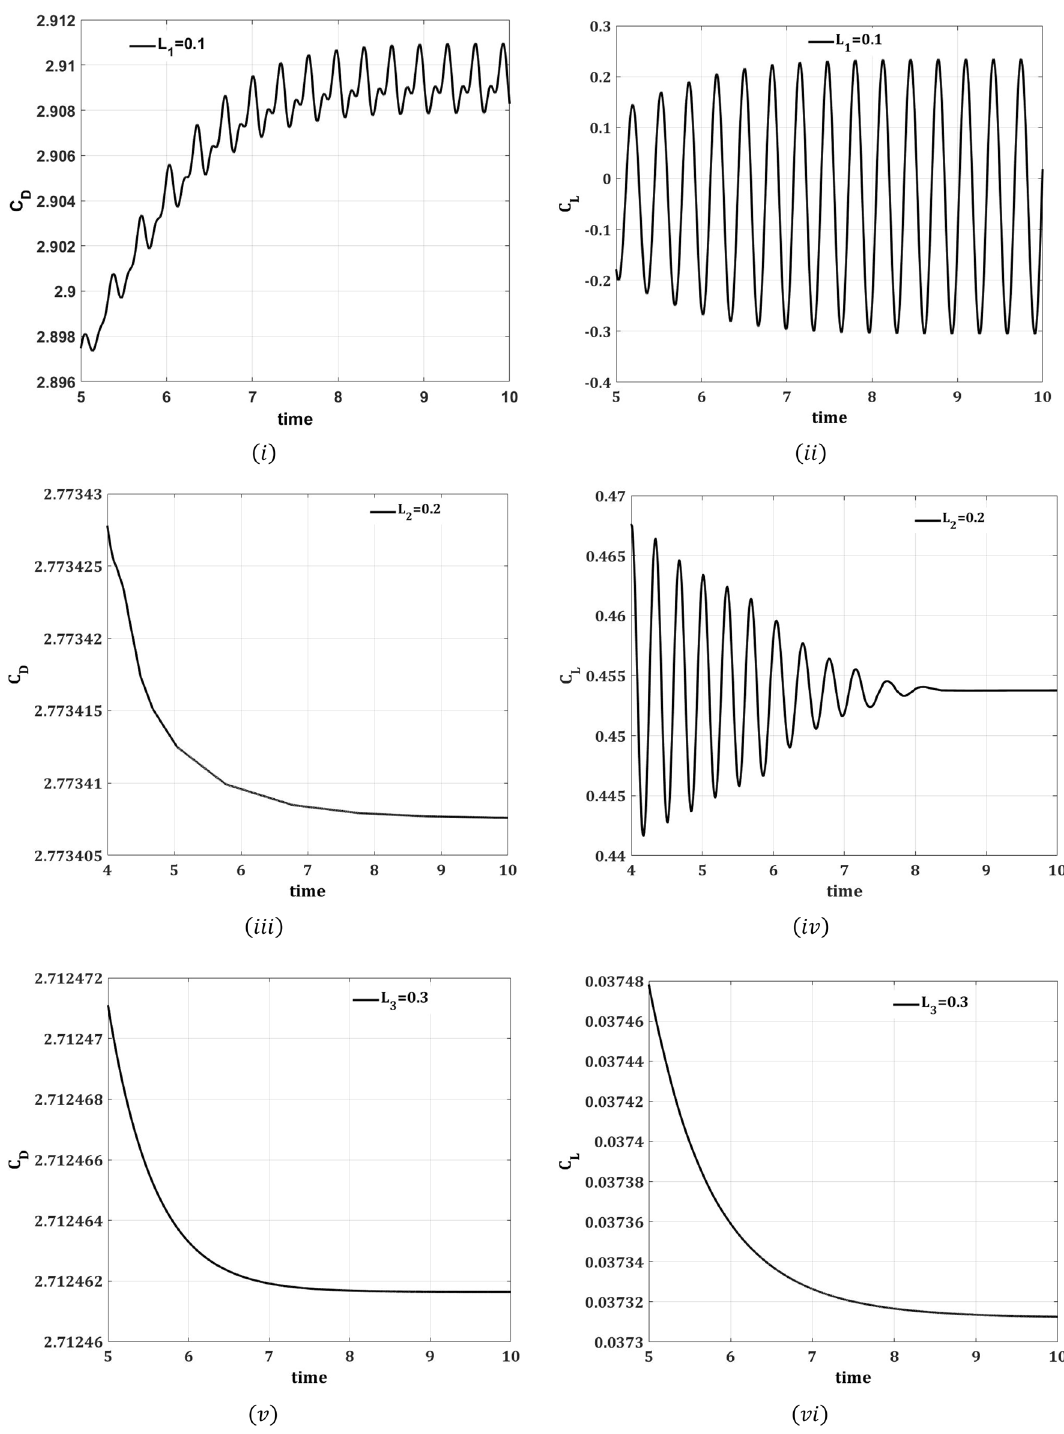
Figure 9. Impact of attached splitter plate on drag coefficient ( C D ) and lift coefficient ( C L ) w.r.t